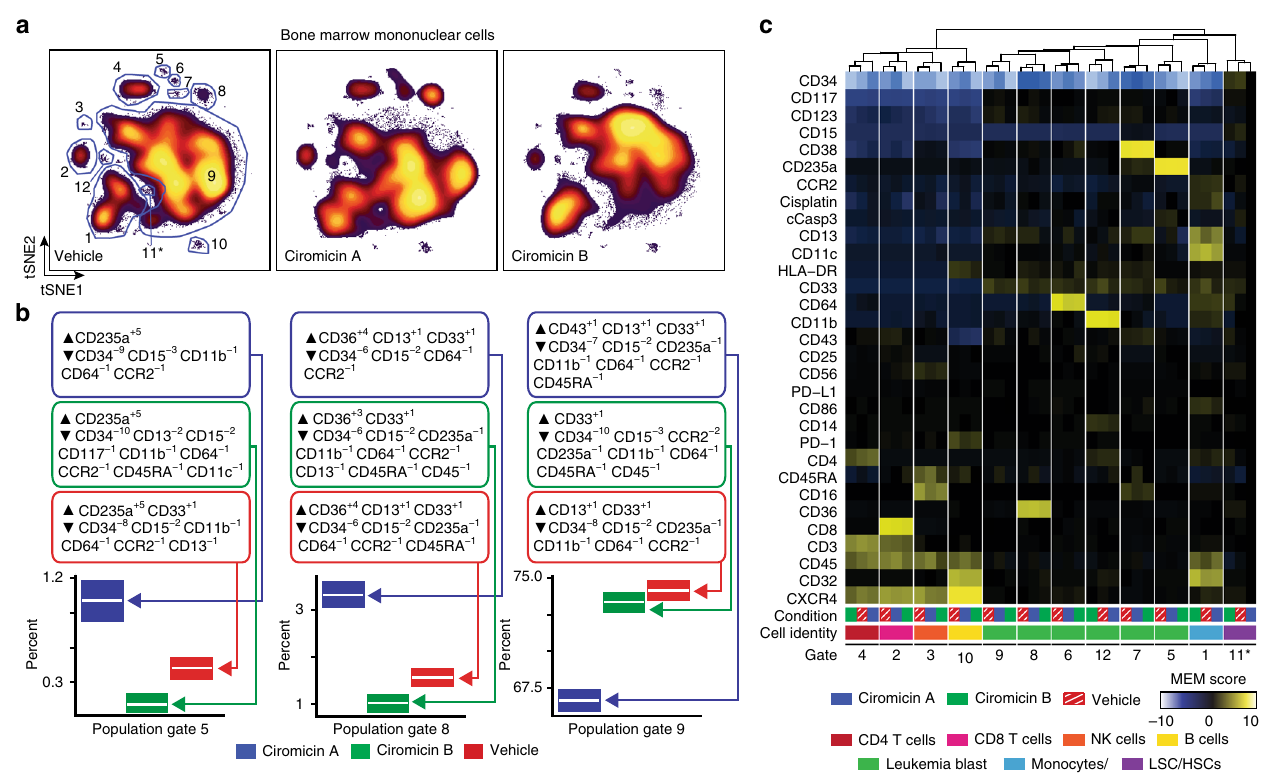
Fig. 5 Photochemical isomers ciromicins A and B selectively target different cell subsets within the heterogeneous mixture of patient biopsy cells. Mass cytometry uses DOTA-chelated metals detected by inductively coupled plasma mass spectrometry (ICP-MS) to eliminate spectral overlap, expanding the feature range to 29 antibody-quanti fi ed features per cell. a viSNE maps of 20,000 individual cells from each condition are organized according to differences in their surface marker pro fi les for each treatment condition. b MEM labels for three blasts subsets and plots of population prevalence with observed prevalence in white and 95% binomial con fi dence interval represented by a box. c Marker enrichment modeling (MEM) was used to characterize major populations within the samples and highlight differences in marker expression relative to a gated population of phenotypic hematopoietic stem cells (gate 11). Heat maps of hierarchical clustered MEM labels reveal subsets speci fi c differences and cellular identi fi cation. Heat maps of median marker expression are shown in Supplementary Fig. 7. Dose – response data against PMBCs from a healthy donor and patient sample 015 are shown